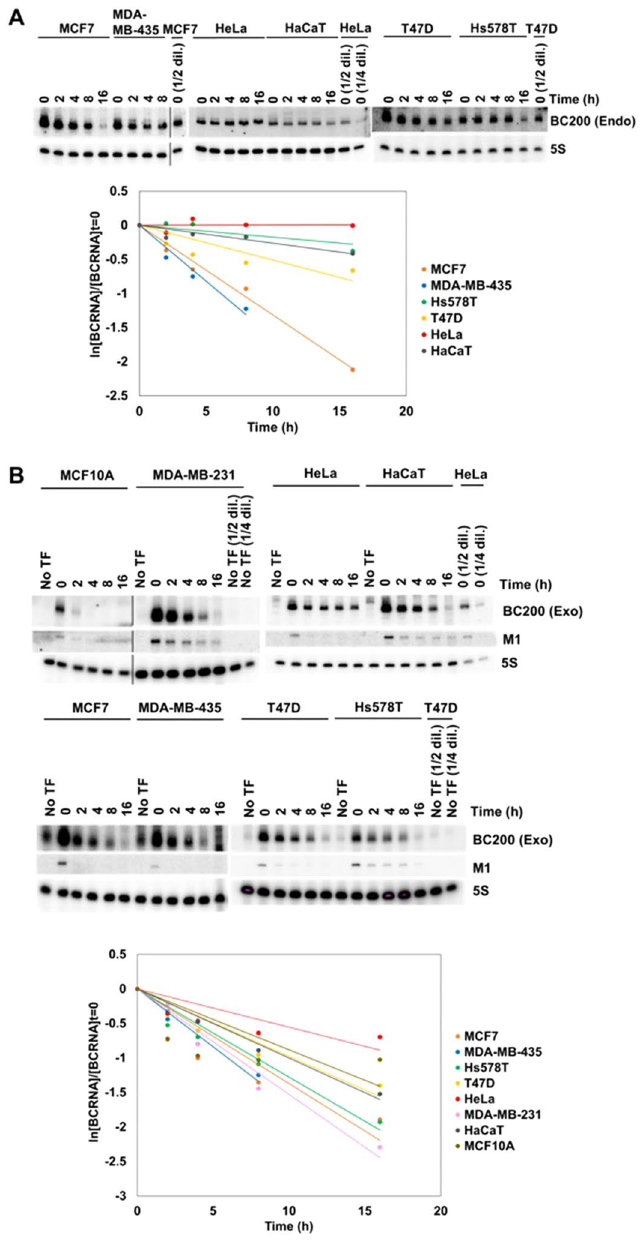
Figure 6. Half-lives of BC200 RNA in cancer cells. ( A ) Endogenous BC200 RNA. Cells were treated with actinomycin D (5 μ g/ml) and harvested at 0, 2, 4, 8 and 16 h post-treatment, and total RNA was purified and analyzed by Northern blotting. Serial dilutions (1/2 and 1/4) of total cellular RNA were used for semi-standard curves (upper panel). Since the same amounts of total cellular RNAs for drug-treated cells were analyzed and rRNAs were the major RNA constitutes, the decrease of 5S rRNA might not be observed during the time course. The remaining BC200 RNA levels (ln[BC200]/[BC200]t = 0) are plotted versus time in hours (lower panel). ( B ) Exogenously expressed BC200 RNA. Various cell lines were transfected with the − 100 upstream construct. The cells were treated with actinomycin D (5 μ g/ml) and harvested at 0, 2, 4, 8 and 16 h post-treatment, and total RNAs were analyzed for exogenous BC200 RNA levels by Northern blotting. The MCF10A, MDA-MB-231 and HaCaT cells were transfected with 3 µ g of the − 100 nt upstream construct expressing BC200 RNA and 3 µ g of the M1 RNA expressing plasmid. The HeLa, MCF7, MDA-MB-435, T47D and Hs578T cells were transfected with 1 µ g of the − 100 nt upstream construct expressing BC200 RNA and 1 µ g of the M1 RNA expressing plasmid. Serial dilutions (1/2 and 1/4) of total cellular RNA were used for semi-standard curves (upper panel). The remaining BC200 RNA levels (ln[BC200]/[BC200]t = 0) are plotted versus time in hours (lower panel). Exogenous BC200 RNA signals were corrected by subtracting the endogenous signal obtained from non- transfected cells (No TF). BC200 (Exo) and BC200 (Endo) stand for exogenous and endogenous BC200 RNA, respectively. In each panel the spliced image from the same Northern membrane was shown with the insertion of a dividing line between spliced